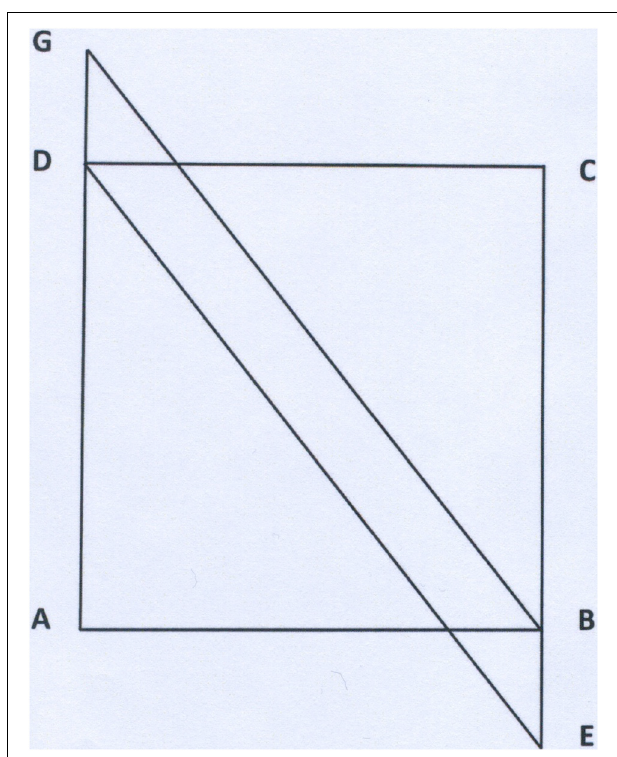
FIGURE 3 | The square and parallelogram problem.